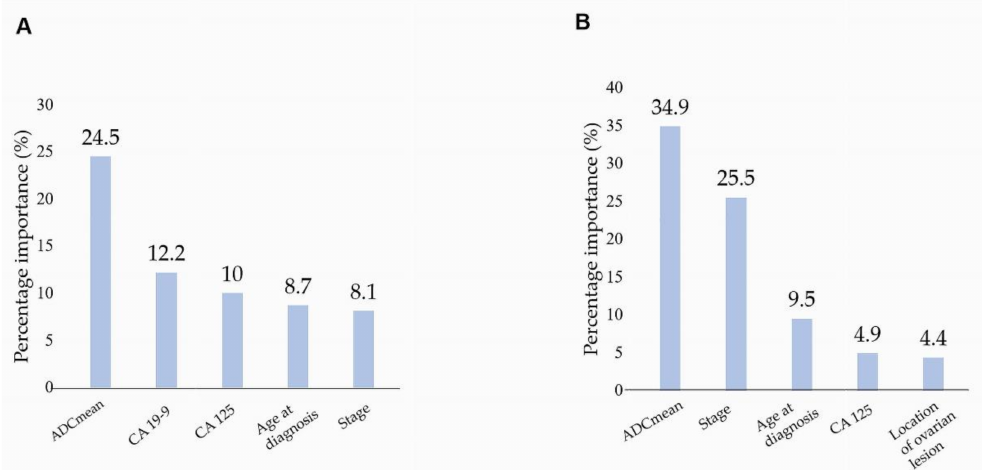
Figure 5. Variable importance by percentage in predicting the outcome. ( A ) Between HGSOC and non-HGSOC, ( B ) among 5 histological types of EOC (HGSOC, EC, CCC, LGSOC, MC). ADCmean: mean value of apparent diffusion coefficient, EOC: epithelial ovarian cancer, HGSOC: high-grade serous ovarian cancer, EC: endometrioid cancer, CCC: clear-cell carcinoma, LGSOC: low-grade serous ovarian cancer, MC: mucinous